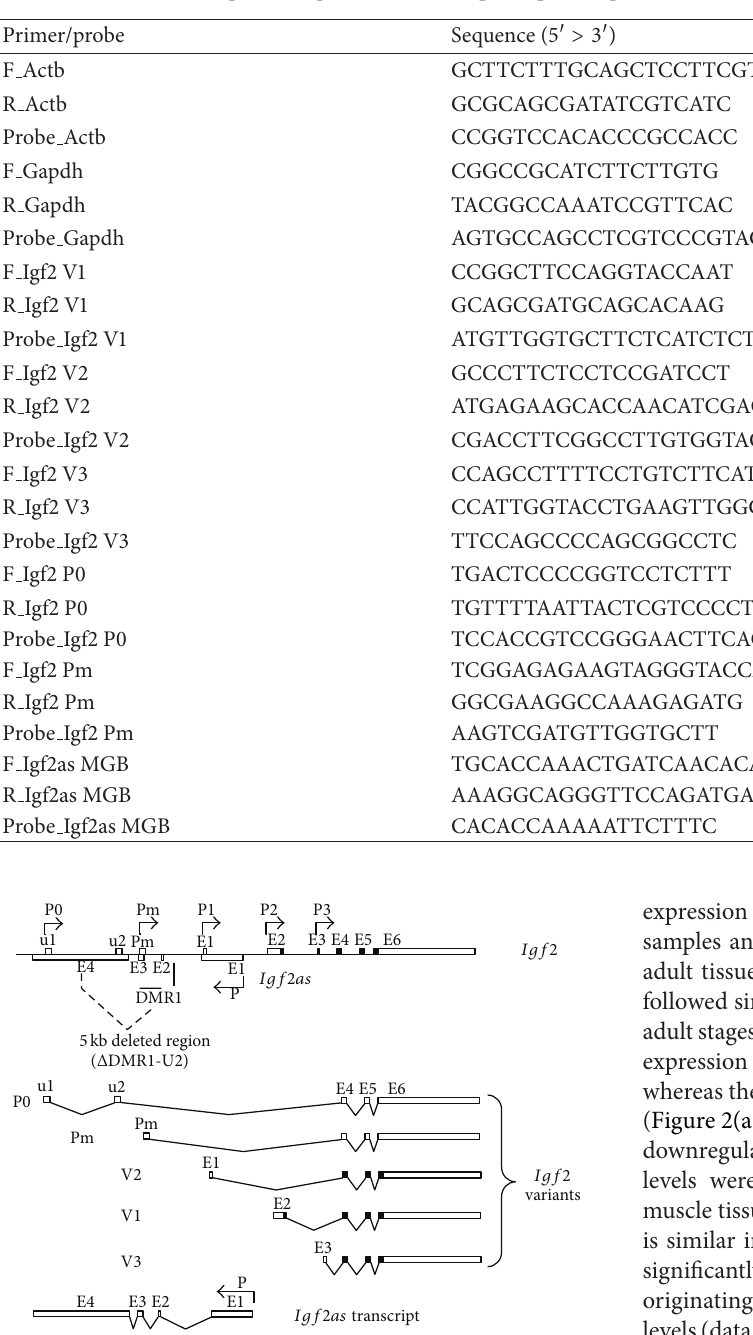
Table 2: Primer pairs and probes used in TaqMan qPCR experiments. Forward (F) and reverse (R) primers are indicated.